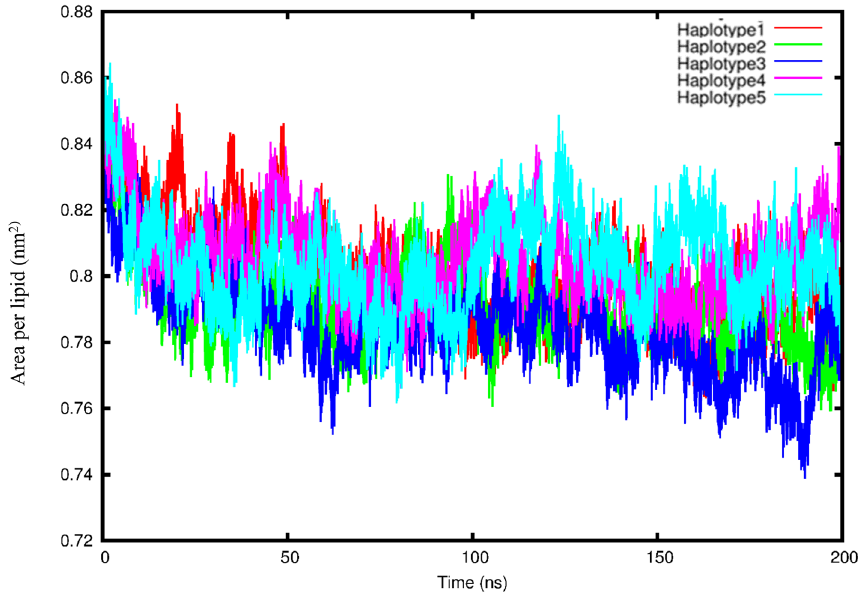
Figure 5. Area per lipid fluctuation for the five haplotype systems over 200 ns.